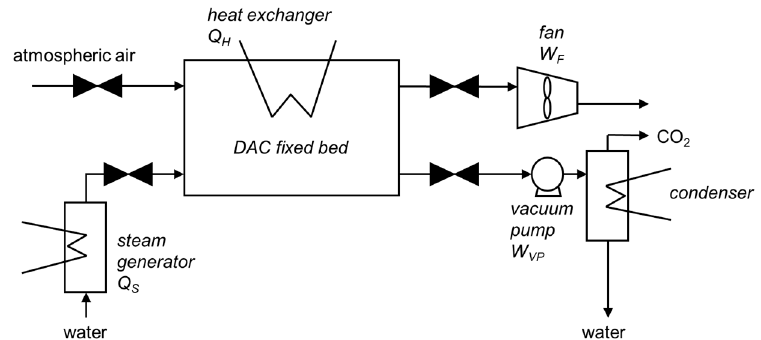
Figure 1. Simplified process flowsheet for adsorption-based DAC technology.